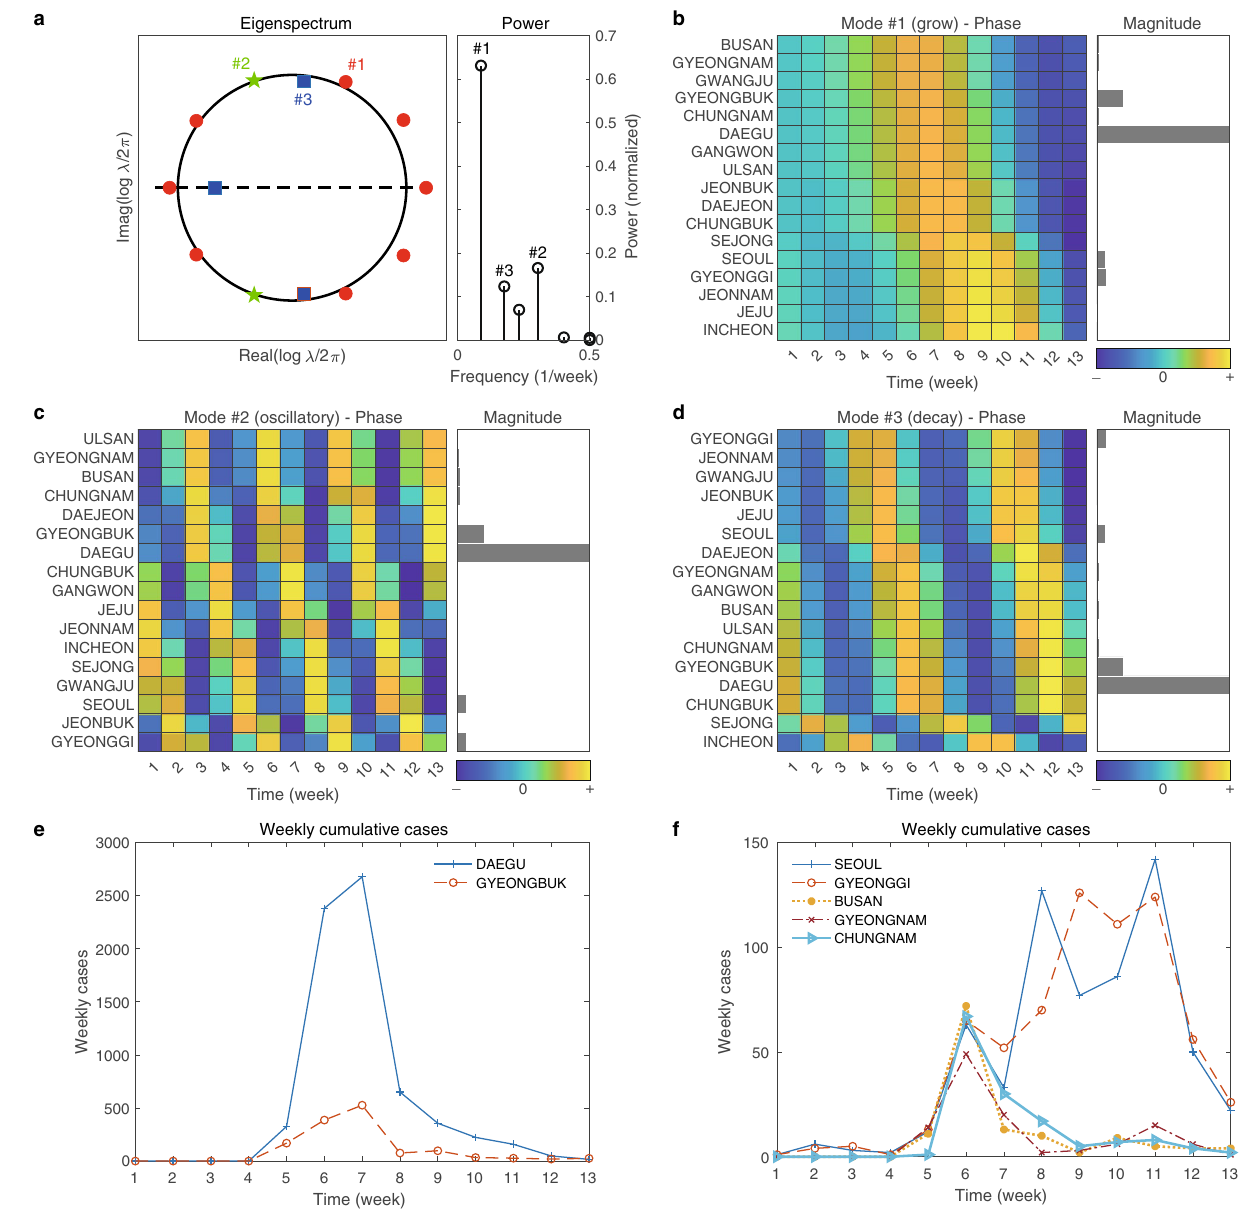
Figure 3. The first wave: DMD eigenvalues and modes. ( a ) shows eigenspectrum { (cid:31) j } j = 1, ··· in the left and p |� α j φ j � F } j = 1, ··· , in the right. The first three DMD modes that represent growing, powers, defined as {| (cid:31) j oscillatory and decaying modes are enumerated as #1 , #2 , and #3 . ( b – d ) Show the phase and magnitude of the selected DMD modes, #1 , #2 , and #3 , respectively. ( e ) and ( f ) show time series of weekly cumulative cases for some selected regions. ( e ) is for high transmission areas, Daegu and Gyeongbuk, while ( f ) is for other relatively low transmission